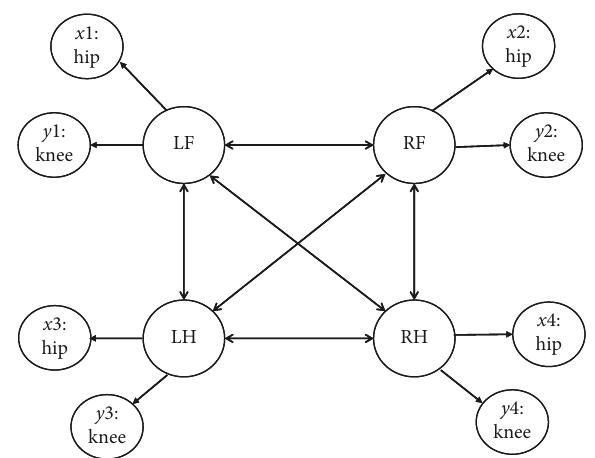
Figure 5: Topological structure of the CPG oscillator